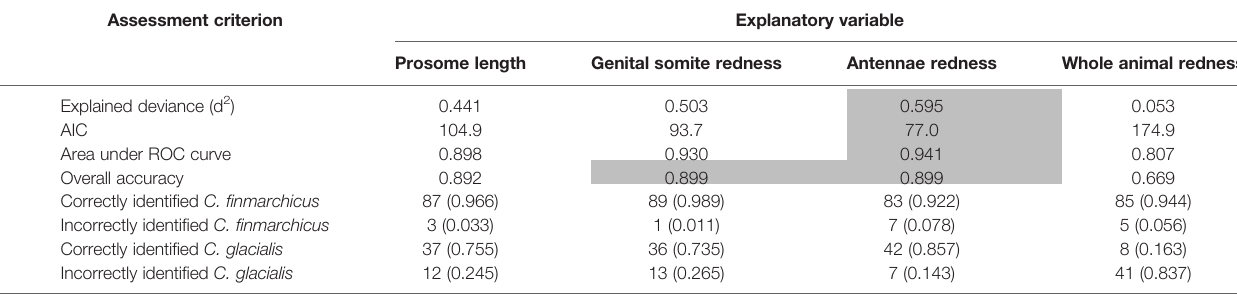
TABLE 1 | Performance metrics (A) and confusion matrices (B) for each of the explanatory variables to discriminate between C. fi nmarchicus (n = 90) and C. glacialis (n =